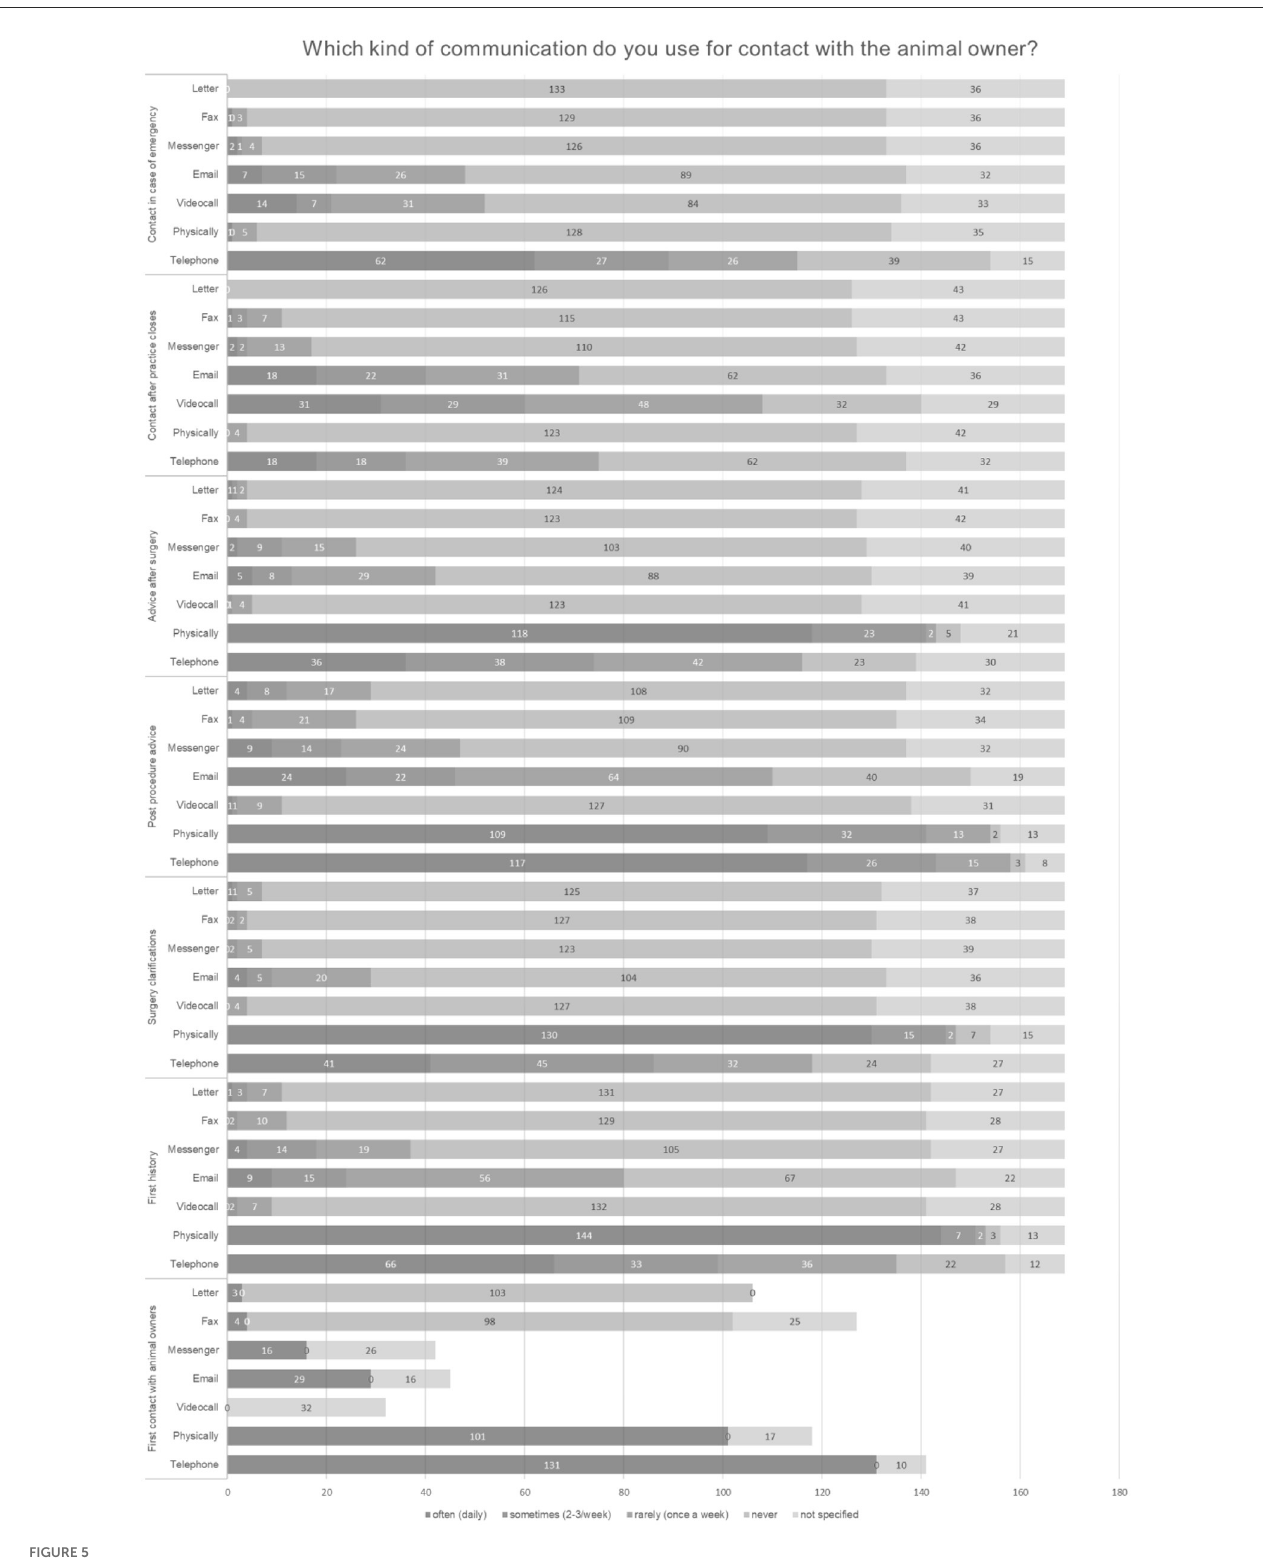
In addition to more information about the legally protected possibilities